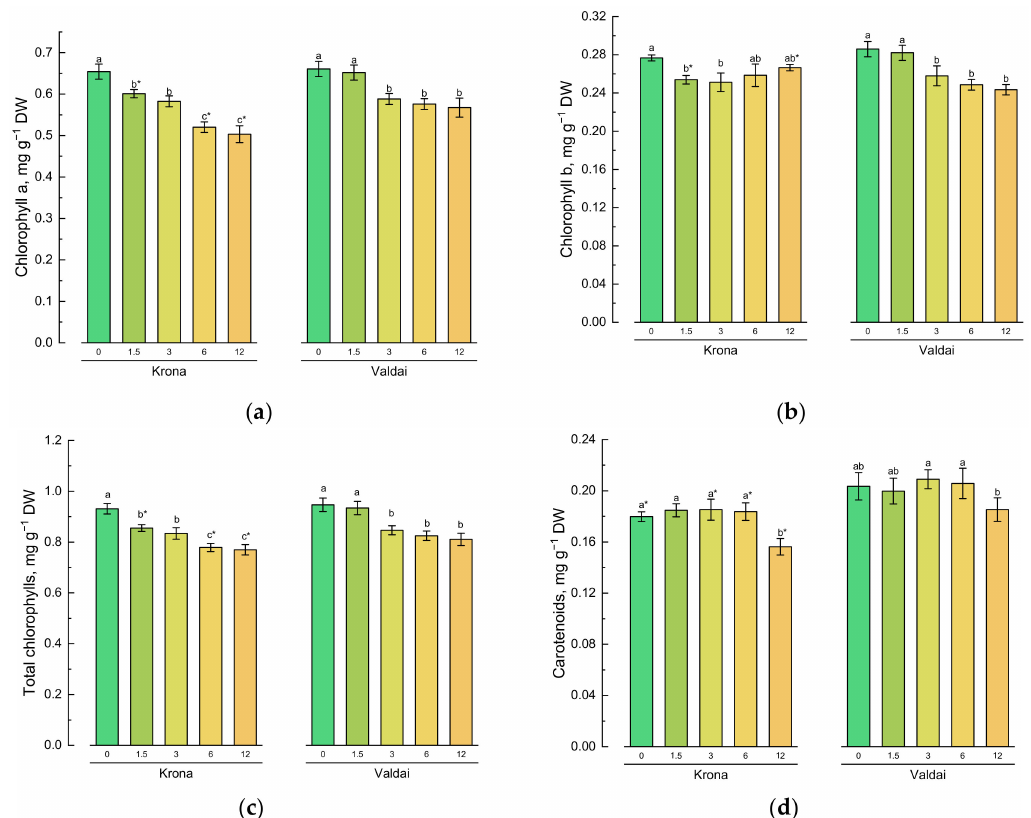
Figure 1. Effect of soil pollution with crude oil (given on X -axis in %) on contents of photosynthetic pigments: ( a ) chlorophyll a , ( b ) chlorophyll b , ( c ) total chlorophylls, and ( d ) carotenoids in shoots of two rye varieties. Different lower-case letters indicate significant differences between plants by oil concentration in the soil for each variety separately, and asterisks * indicate significant differences between rye varieties at p ≤ 0.05 based on post hoc Tukey’s test ( n =